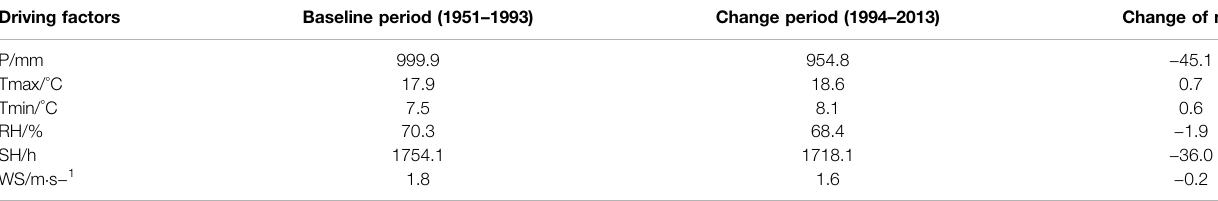
TABLE 2 | Mean values of the meteorological factors in the UYRB for baseline period and change